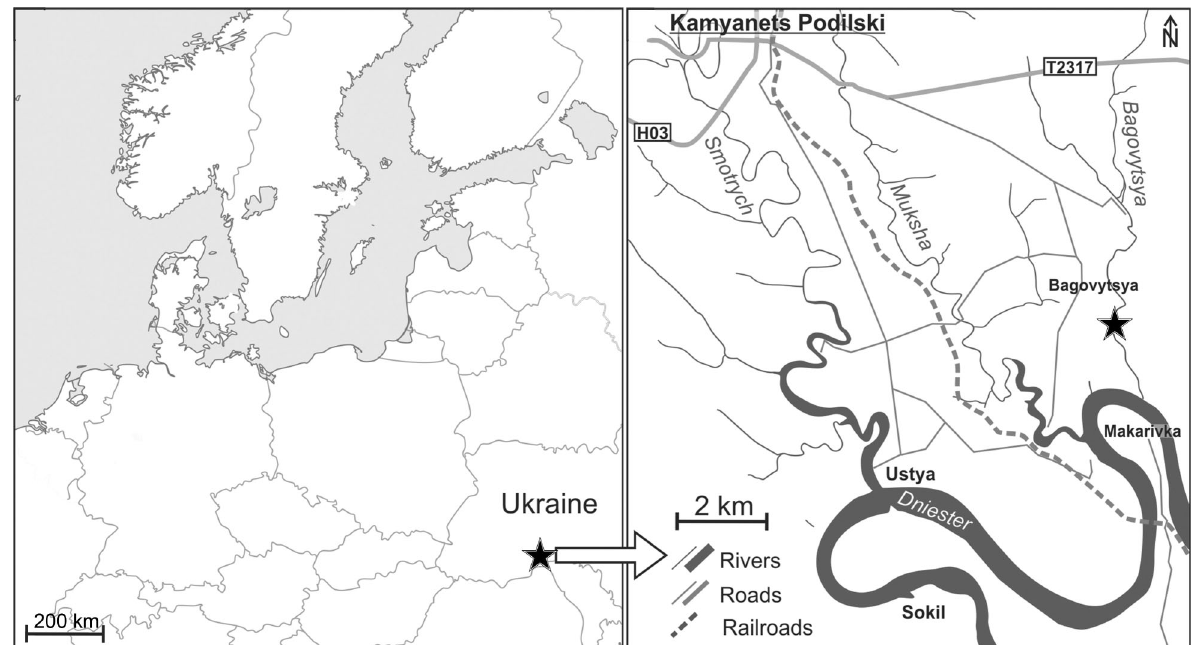
Fig. 1. Overview map showing location of the study area in Ukraine (modified from Jarochowska et al. 2014). The locality is shown with a black